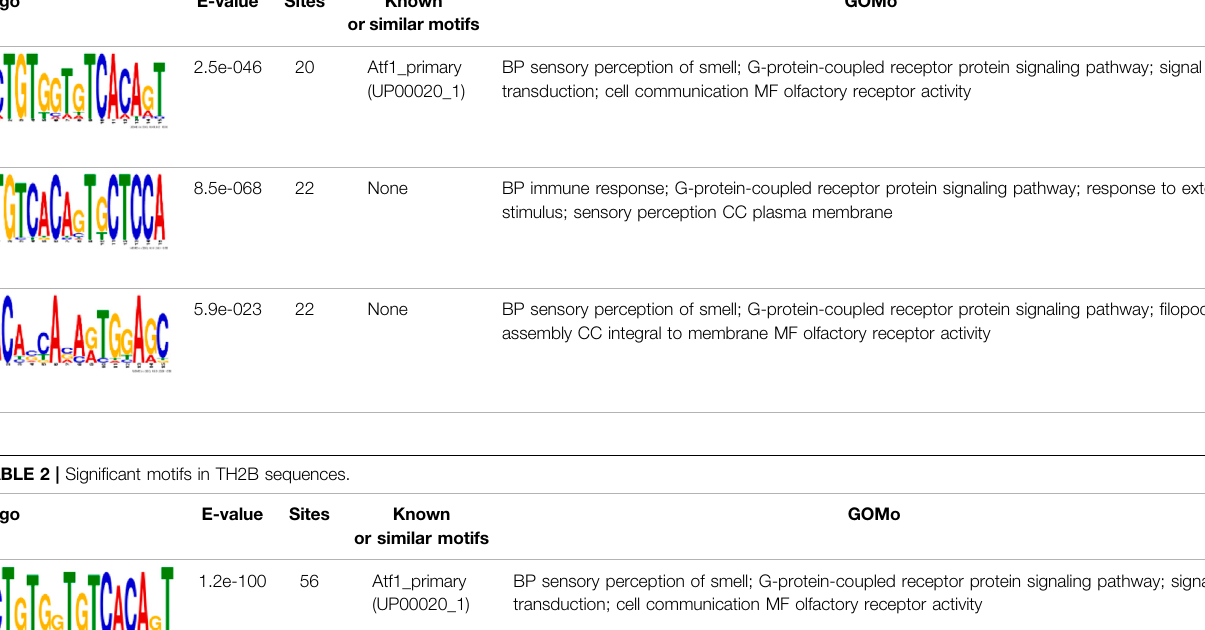
TABLE 1 | Signi fi cant motifs in TH2A sequences. Logo E-value Sites Known